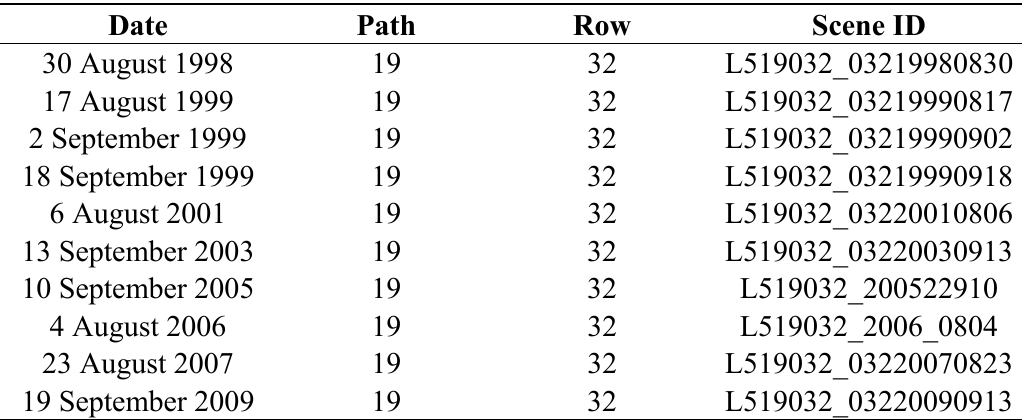
Table 1. Image data set used in the